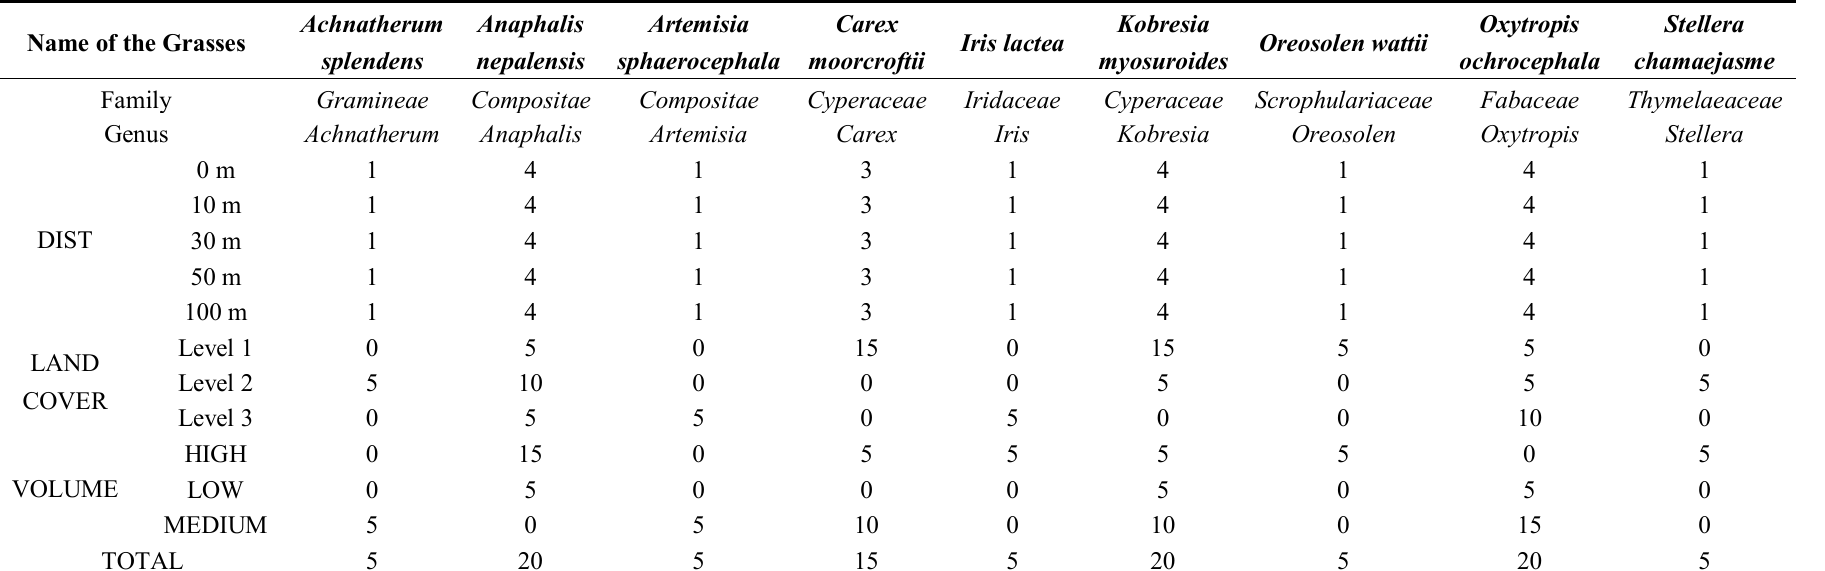
Table 3. Sample size and description of variables related to each grass